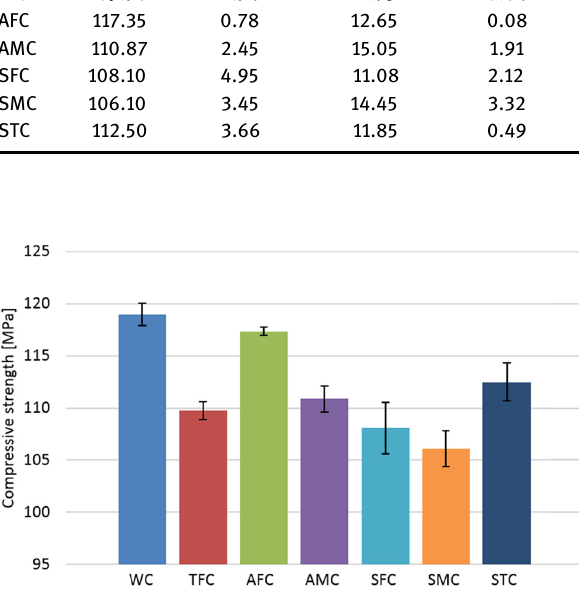
Figure 6: Results for compressive strength.